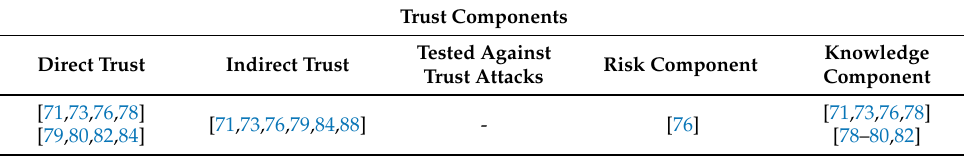
Table 7. Research on MAS-based trust in Smart Grid categorized by trust components.